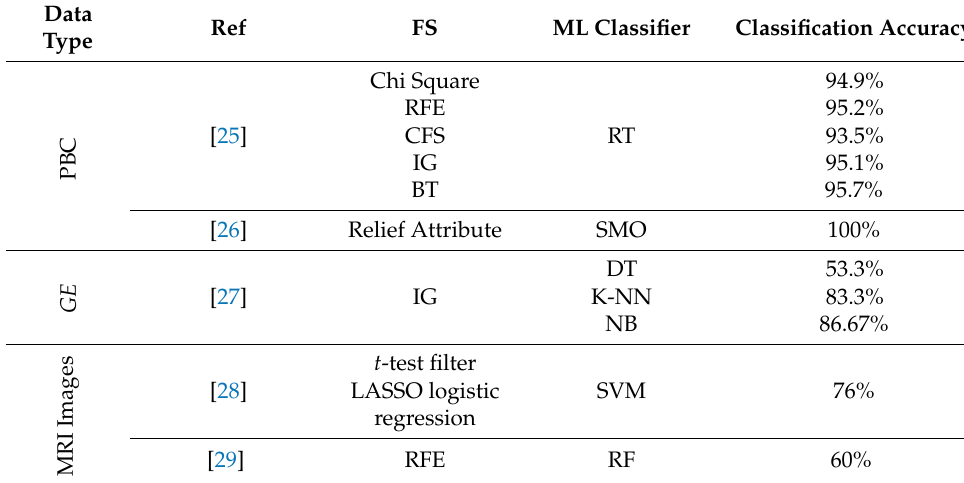
Table 2. ASD prediction using ML with simple FS.